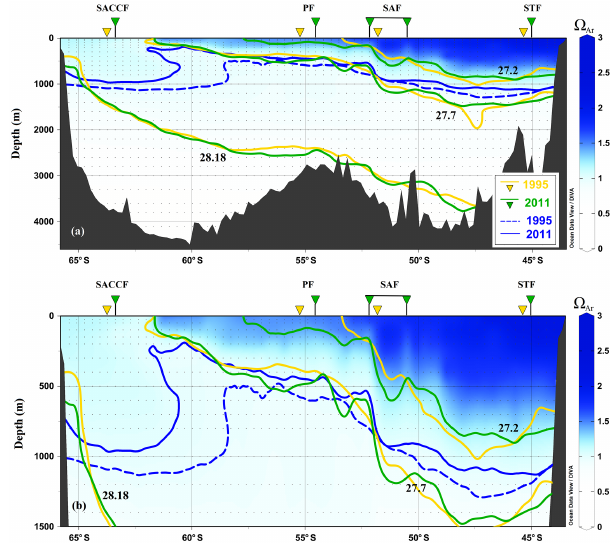
Figure 3. Aragonite saturation depth (ASD, (cid:127) Ar = 1) for the 1995 and 2011 cruises. (a) Distribution of ASD (blue dotted and solid lines) and γ n (green and yellow lines) in latitude in the SR03 sec- tion. (b) Section zoomed for the first 1500m of the water column. The position of the fronts (triangles) in 1995 (yellow) and 2011 (green) is also shown. The blue palette in the background indicates the distribution of (cid:127) Ar for the 2011